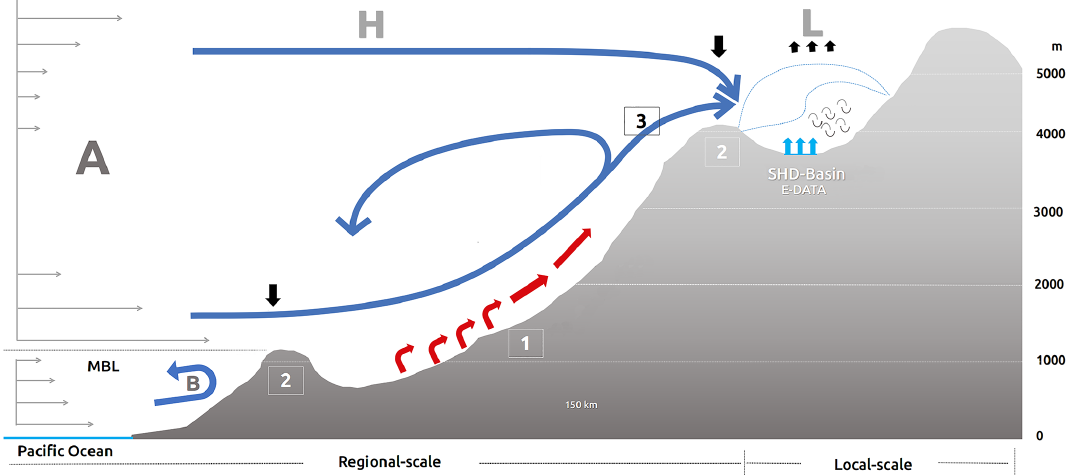
Figure 11. The regional and local circulation patterns that act between the Pacific Ocean and the western slope of the Andes. “H” and “L” (black arrows) represent the synoptic high and low pressures. “A” corresponds to the regional zonal circulation from the top of MBL, and “B” corresponds to the zonal circulation within the MBL resulting from the coastal daytime warming. Grey arrows (left) represent the regional zonal wind intensity. “1” (red arrows) indicates the anabatic flow. “2” schematizes the topographic channelling process. “3” (blue arrows) shows the advection. Blue dotted line represents the formation of boundary layers and cyan arrows the E produced by turbulence (circular